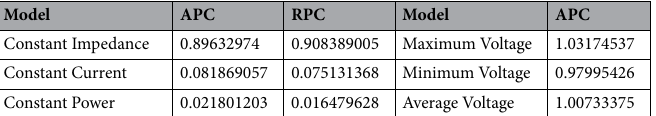
Table 7. Nueva Prosperina ZIP static load model coefficients and Voltage bus values.